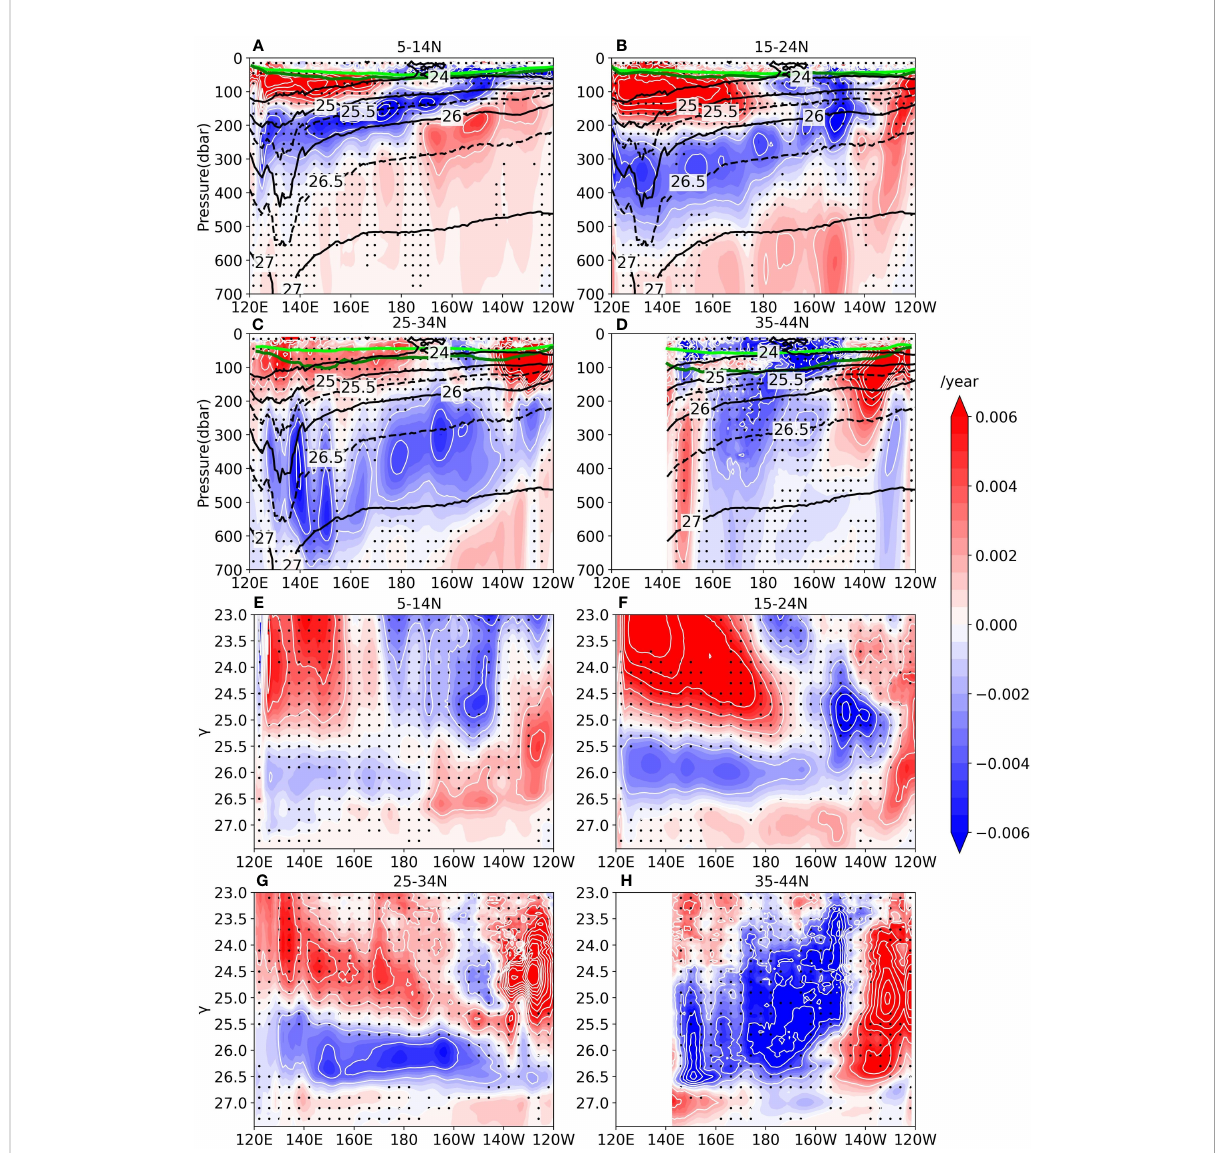
FIGURE 4 Linear trend of salinity (color and white contours were every 0.002) (unit = year − 1 ) with respect to (A – D) pressure and (E – H) g during 2004 – 18, which were averaged in (A) and (E) 5 – 14°N, (B) and (F) 15 – 24°N, (C) and (G) 25 – 34°N, and (D) and (H) 35 – 44°N. Stippled grids indicate where a trend was insigni fi cant at 95% con fi dence level. In (A – D) , the light and dark green lines represent all-season mixed layer depths and depths in February – March, respectively. The black contours indicate a climatological neutral density (unit = kg·m − 3